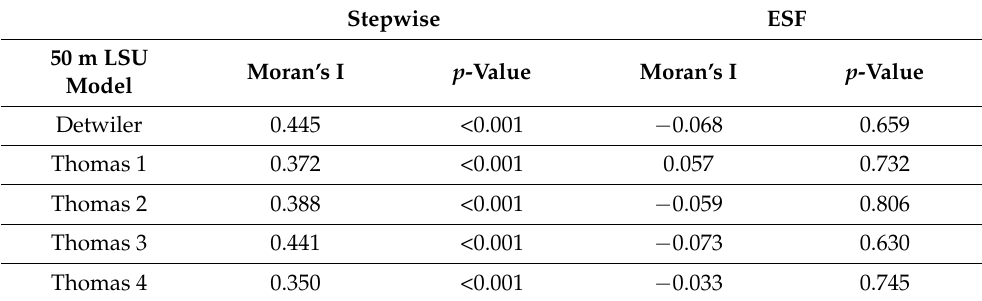
Table 3. Residual Moran’s I of 50 m LSU models for stepwise regression and ESF regression. Stepwise ESF